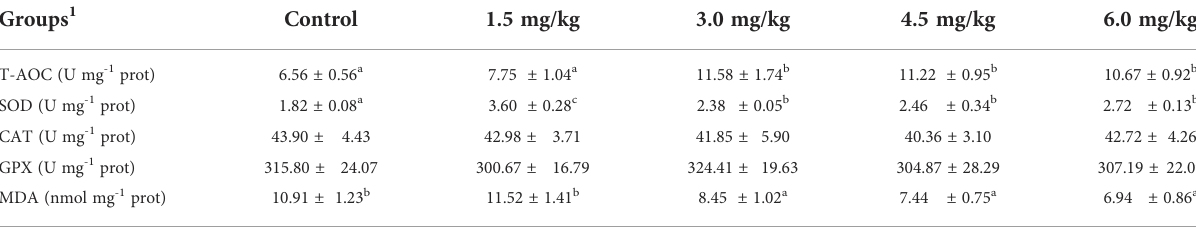
TABLE 6 Effects of PQQ on antioxidant capacity in the serum of yellow cat fi sh. Groups